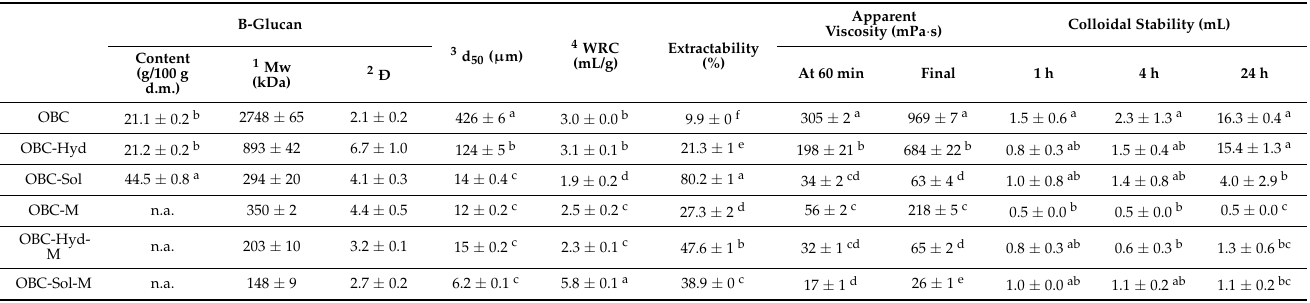
Table 1. Characteristics of OBC samples: β -glucan content, average particle size, WRC, extractability and properties in suspension.